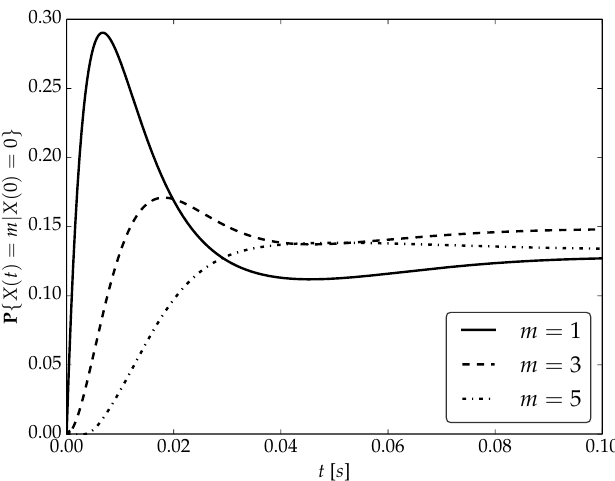
Figure 2. Transient probabilities P equal 2 ms.